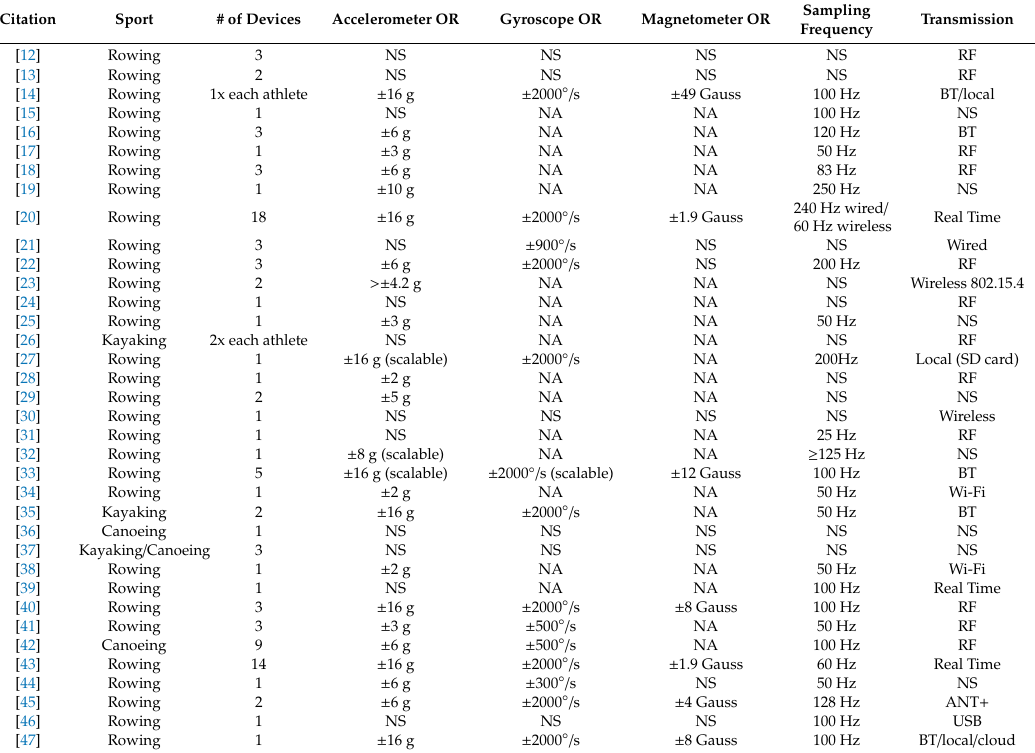
Table 4. Properties of inertial sensor instrumentation, Number (#) of devices; OR (Operating Range); RF (Radio Frequency); BT (Bluetooth); ANT (Adaptive network technology); NS (Not Stated); NA (Not